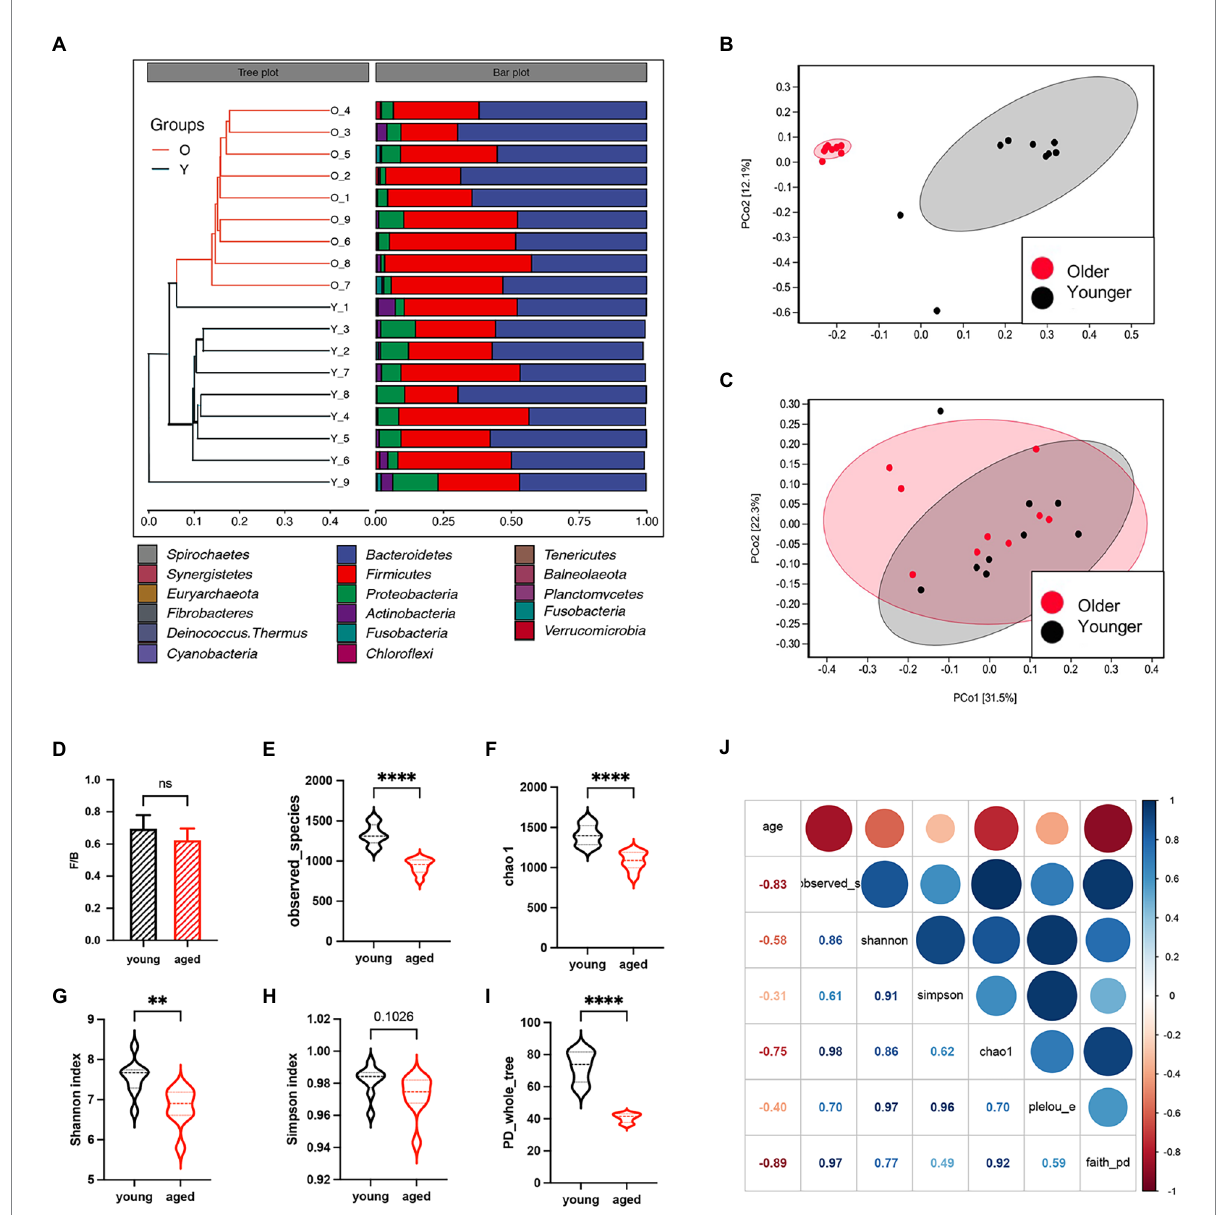
FIGURE 1 Gut microbiota between healthy older and younger people. (A) Unweighted pair group method with arithmetic mean clustering of samples shows younger and older groups were separated in the phylogenetic tree. (B) Principal coordinates analysis based on weighted UniFrac metrics. (C) Principal coordinates analysis based on unweighted UniFrac metrics. (D) The Firmicutes/Bacteroidota ratio of the two groups. (E–I) Alpha diversity indicators of the two groups. (J) The heatmap of correlation between alpha diversity and